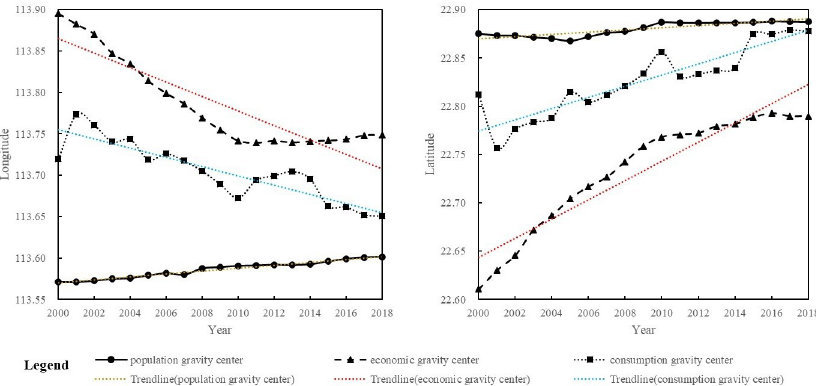
Fig 8. Comparison of the latitudes and longitudes of the population, GDP and total retail sales gravity centers in the GBA.